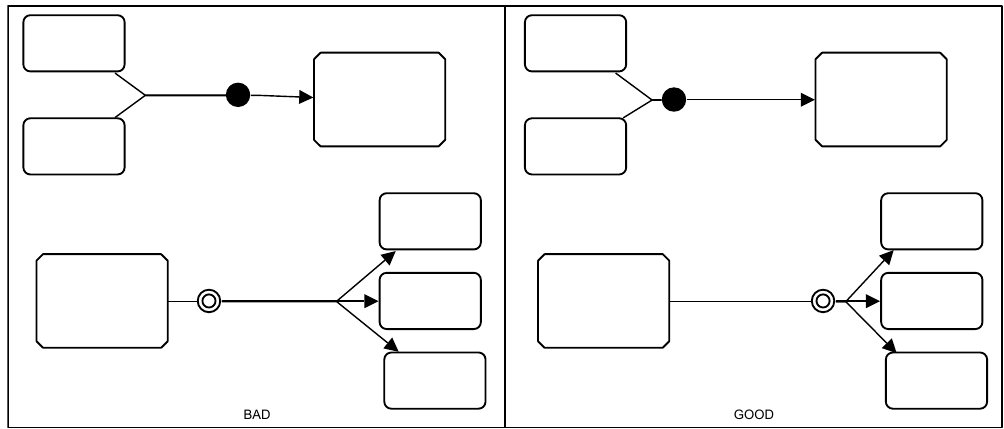
Figure 4.7: Branching points should be close to association and dissociation symbols.